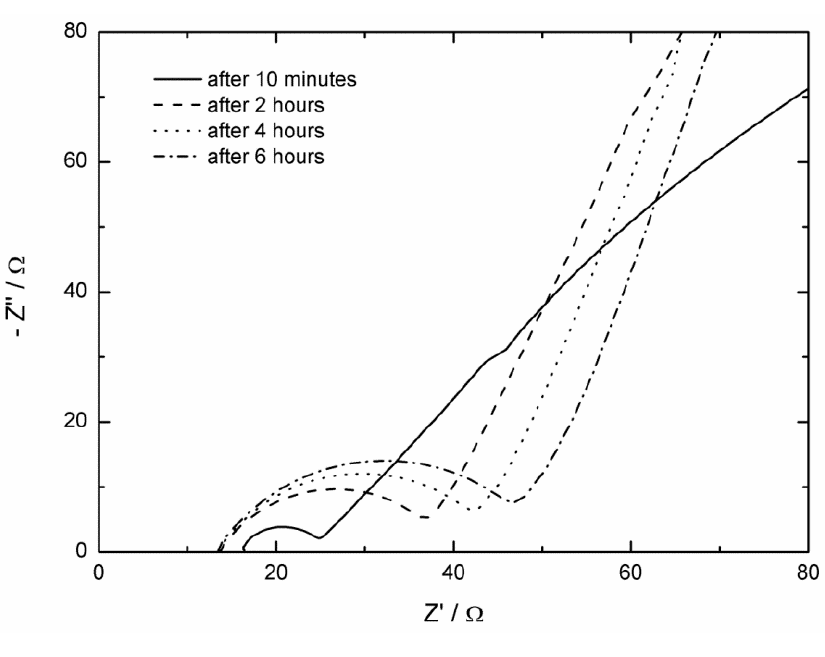
/electrolyte/Li -cell with 1 M deposited deposited